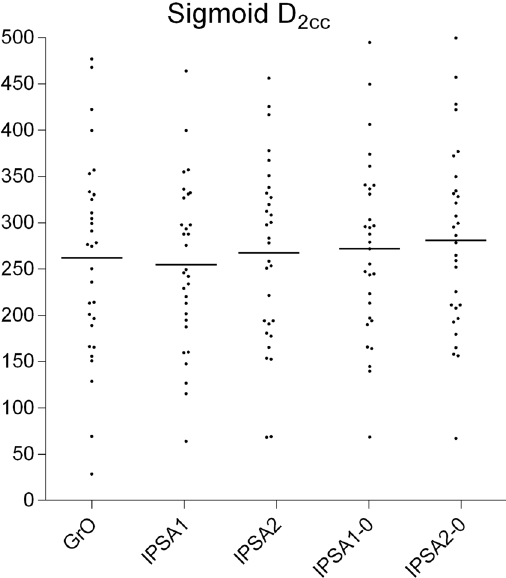
Figure 5. Comparison of sigmoid D 2cc among different plans.